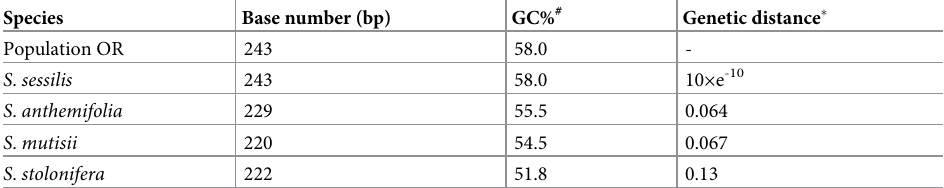
Table 5. Internal transcribed spacer 2 (ITS2) region properties of different Soliva species and clopyralid-resistant S . sessilis population